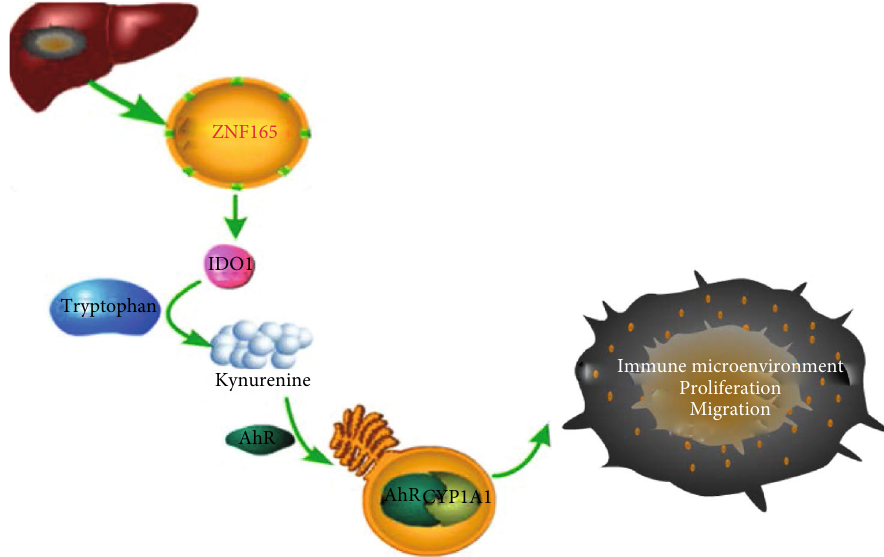
Figure 6: A schematic diagram showing the mechanism of ZNF165 modulating CYP1A1 through AhR, therefore a ff ecting liver cancer cell